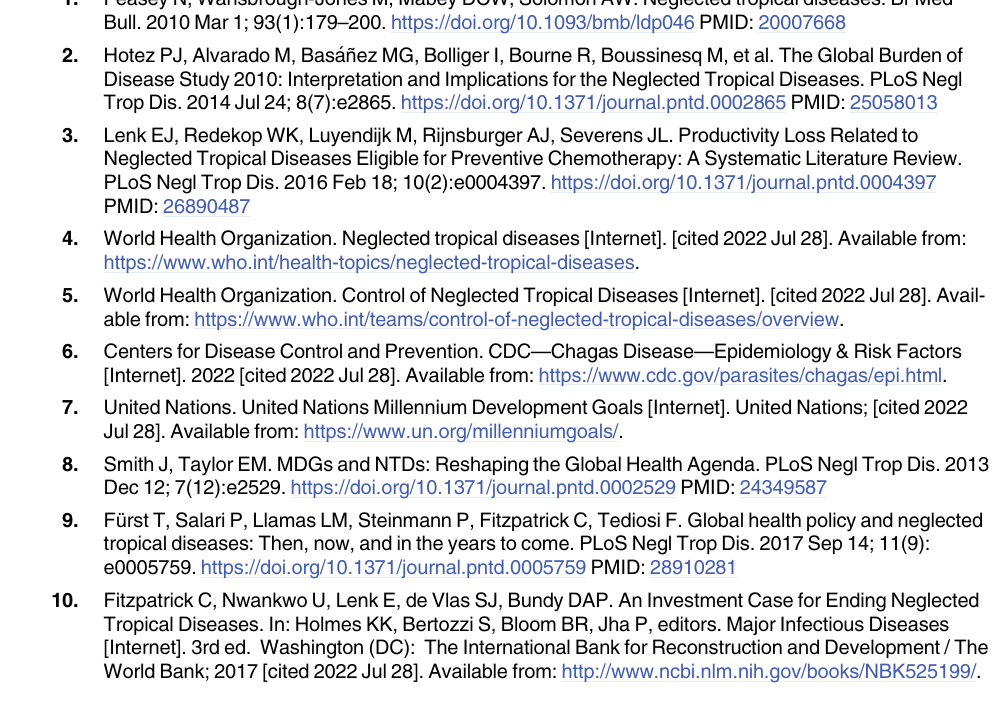
S4 Table. List of guidance documents published by FDA related to production of medical products for tropical diseases. This list includes guidance documents that have been finalized as of July 2022. Guidance documents were extracted from https://www.fda.gov/regulatory- information/search-fda-guidance-documents using relevant search